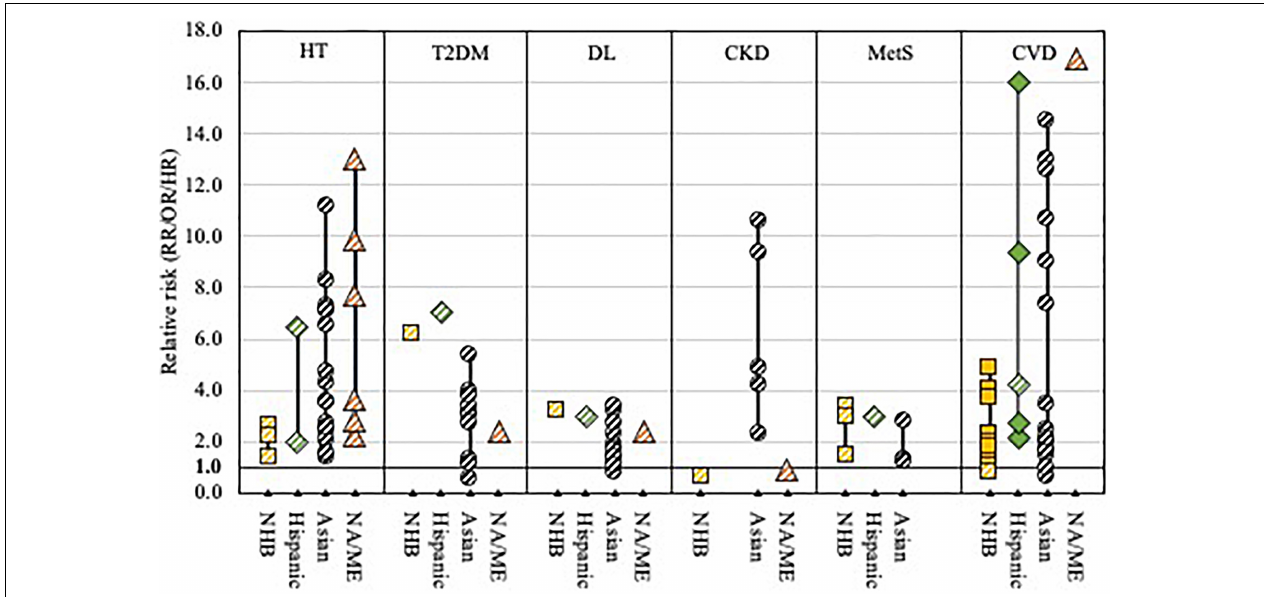
FIGURE 3 | Visual representation of point estimates for CVD risk and CVD risk factors reported in the included studies across races and ethnicities. Non-Hispanic Black, African American or Black women; Latina or Hispanic women; Asian women; North African or Middle Eastern women (NA/ME); living in country of origin; living in the US. Note: study quality and precision of the estimates were not accounted for in the figure, and it should thus be interpreted as an overview of the available evidence, not as a formal statistical summary. HT, hypertension; T2DM, type 2 diabetes mellitus; DL, dyslipidemia; CKD, chronic kidney disease; MetS, metabolic syndrome; CVD, cardiovascular